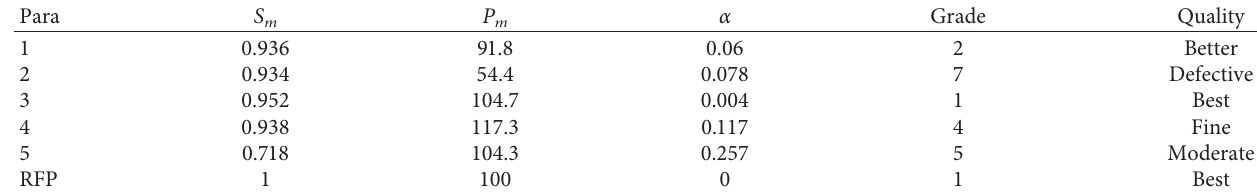
Table 10: Evaluation results of Pulsatilla chinensis total saponin extracts by SQFM. Para S m P m